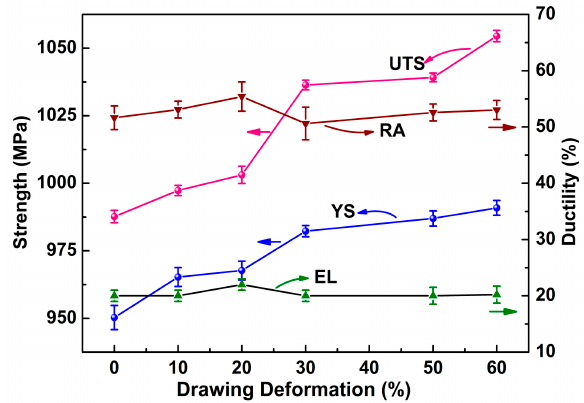
Figure 7. Variation of tensile properties of warm-drawn states as a function of drawing deformation. RA: reduction in area; UTS: ultimate tensile strength; YS: yield strength; EL: elongation.